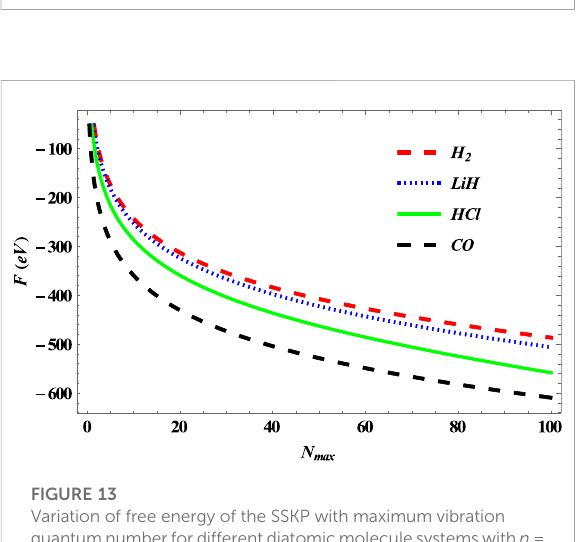
FIGURE 12 Variation of the partition function of SSKP with maximum vibration quantum number for different diatomic molecule systems with n = 2 and l = 1.